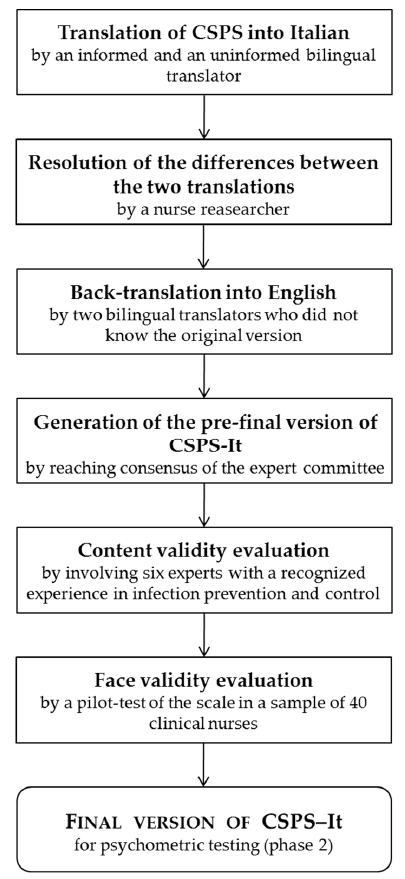
Figure 1. Methodological steps of phase 1.